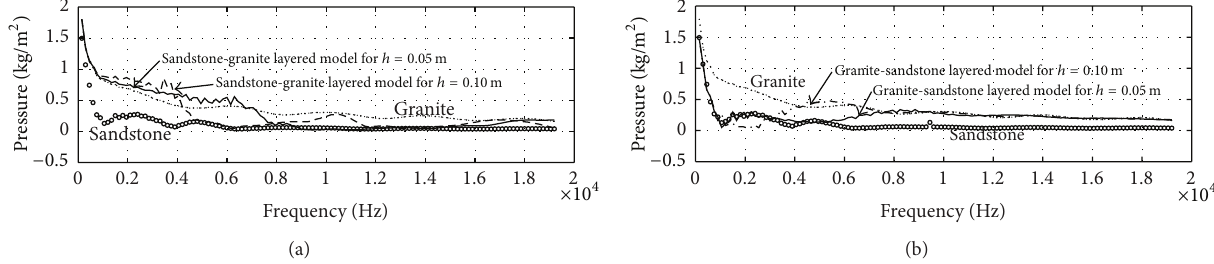
Figure 4: Spectrum of pressures by IBEM for cases 3 to 6 is shown. Cases 3 and 4 are plotted with dotted (granite) and circle (sandstone) lines, respectively. Moreover, in (a) case 5 , sandstone-granite layered model for ℎ = 0.05 m (solid line) and for ℎ = 0.10 m (dashed line) is plotted, and (b) case 6 , granite-sandstone layered model for ℎ = 0.05 m (solid line) and for ℎ = 0.10 m (dashed line) is displayed.